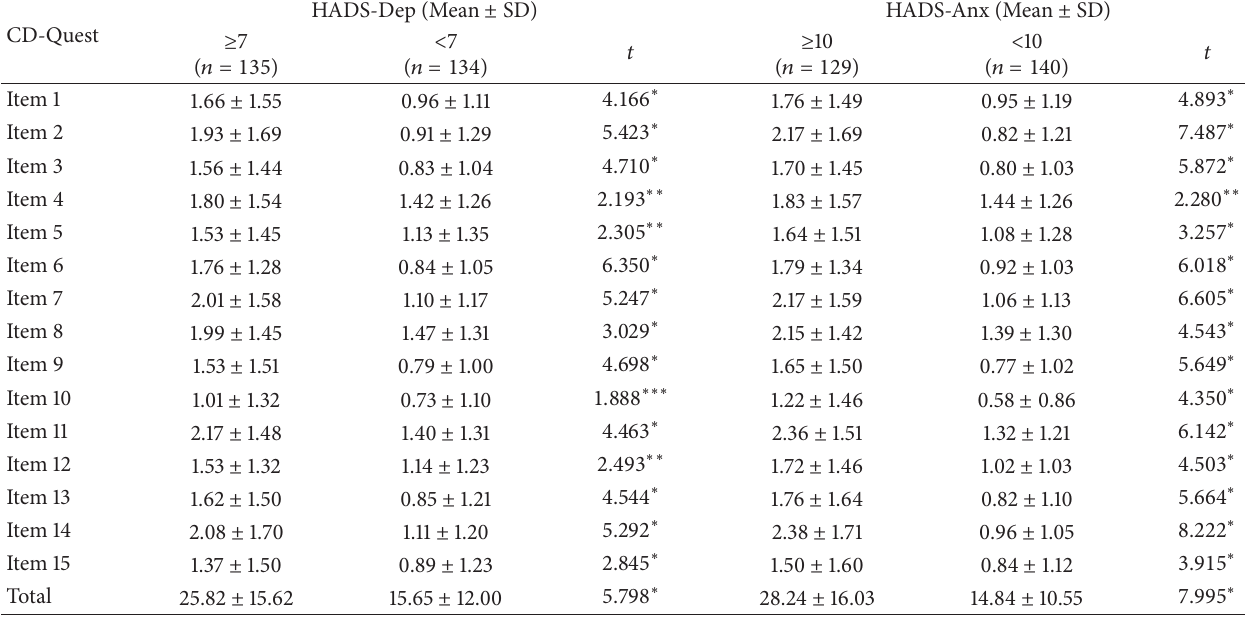
Table 4: Discriminating between clinical and nonclinical participants according to the CD-Quest scores. CD-Quest